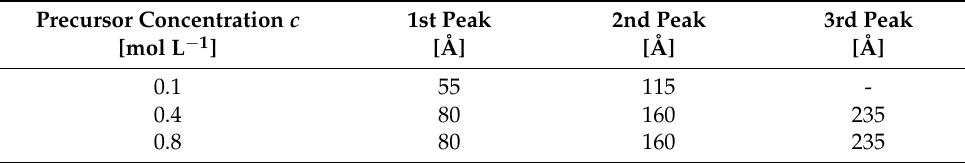
Figure 6. Volume size distribution with numbered peak calculated from SAXS data of primary particles made by SFS with three different precursor concentrations. Table 2. Diameters of the peak positions of the volume size distribution calculated from SAXS data of Figure